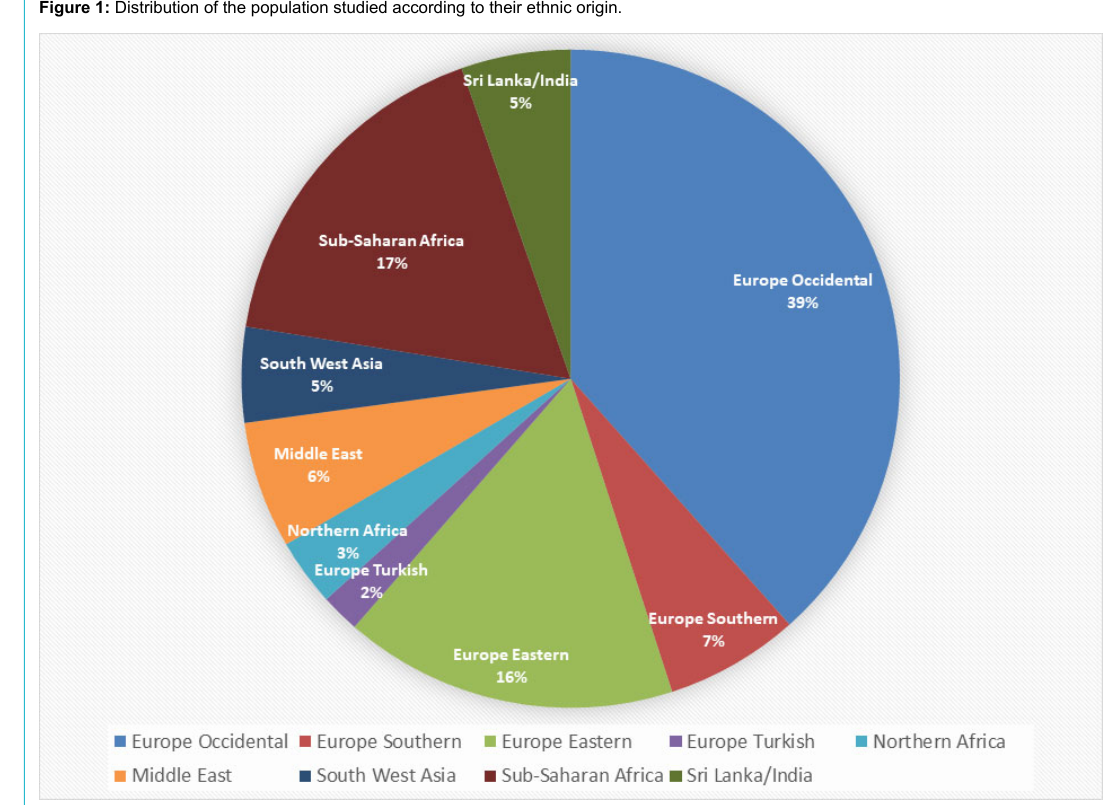
Figure 1: Distribution of the population studied according to their ethnic